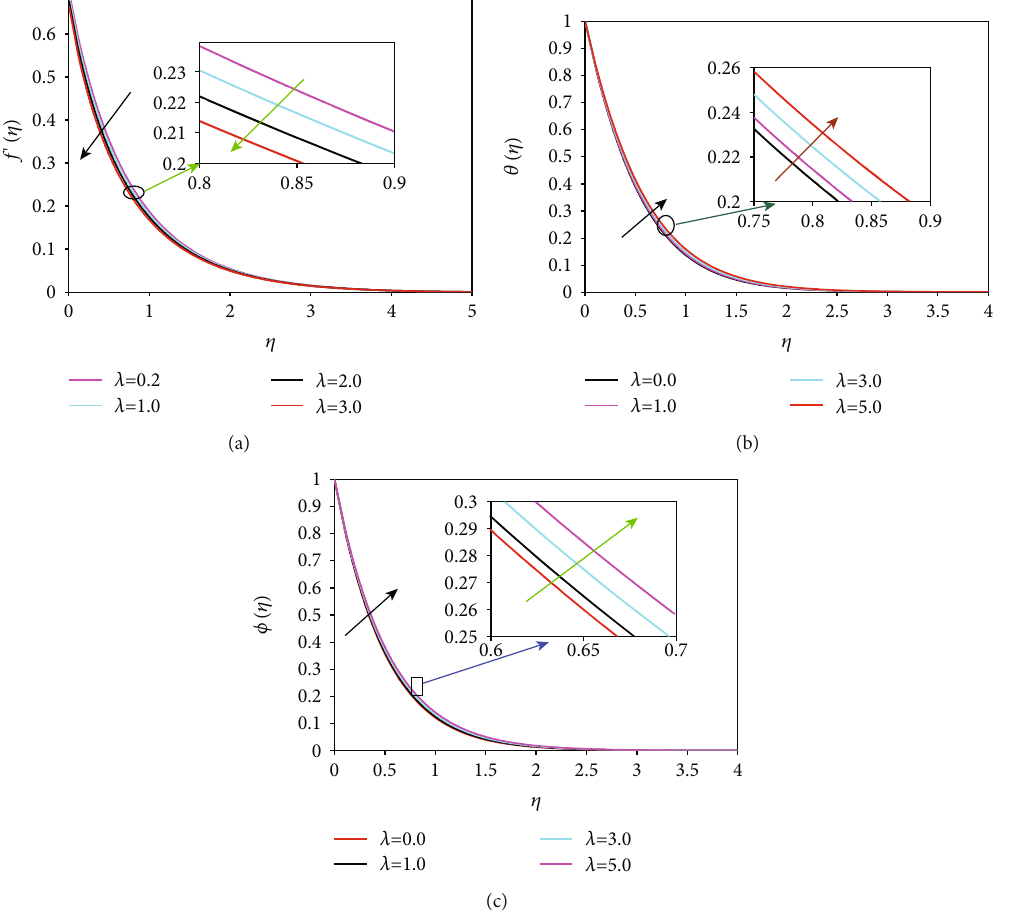
Figure 12: The graph of velocity, temperature, and concentration for di ff erent values of Williamson parameter λ